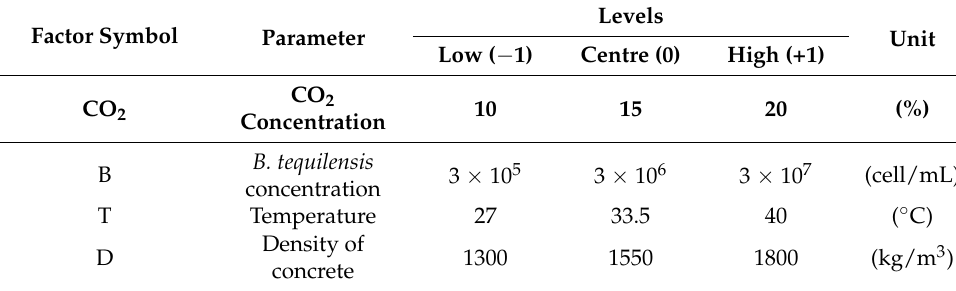
Table 3. Design scheme and levels of the process